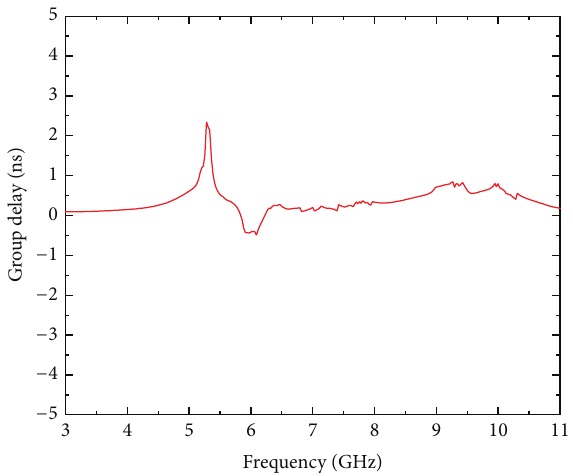
Figure 23: Simulated group delay of proposed MIMO